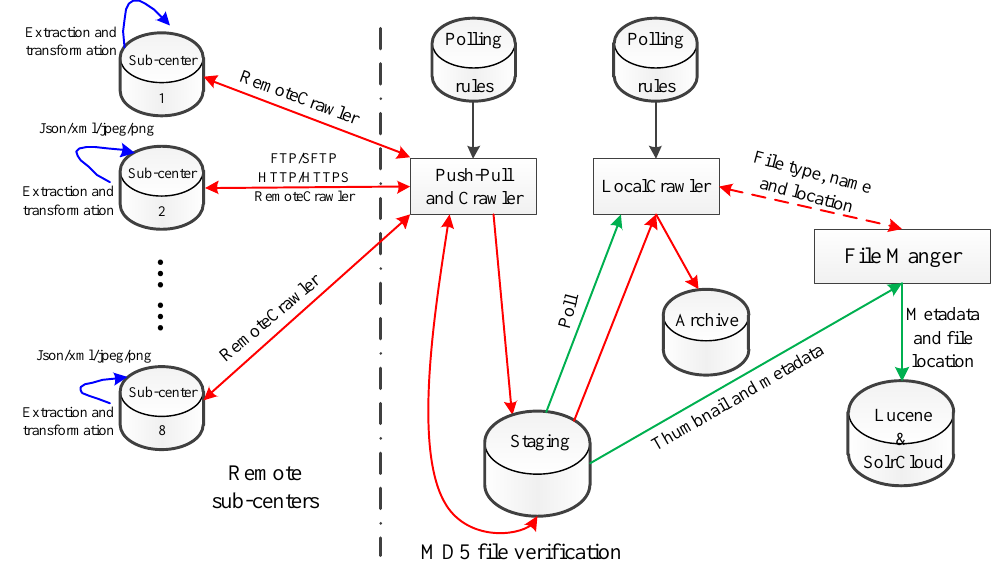
Figure 2. The process of distributed data